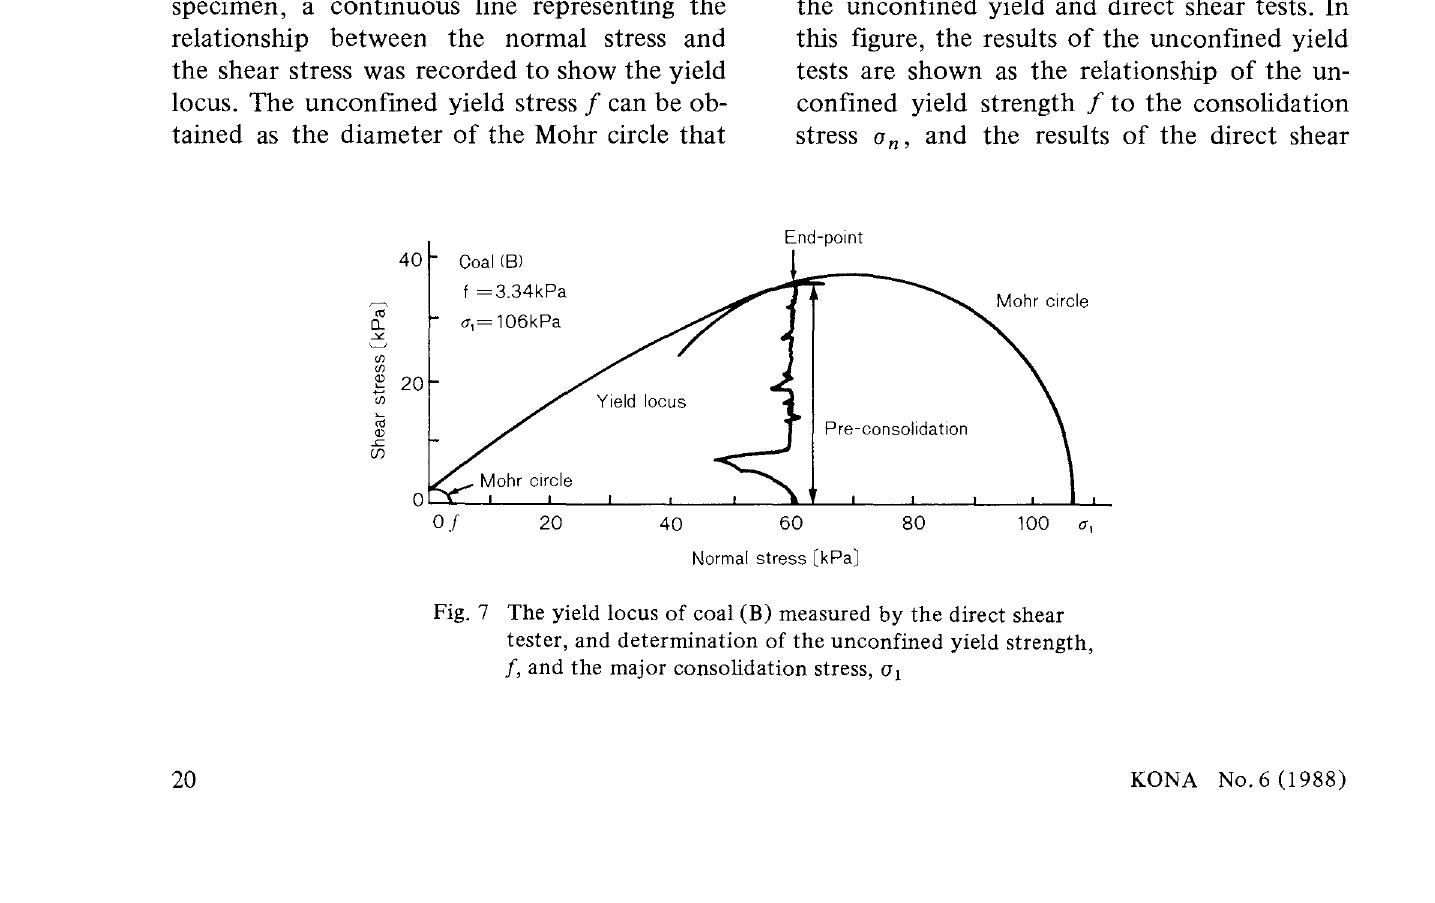
Fig. 7 The yield locus of coal (B) measured by the direct shear tester, and determination of the unconfined yield strength, [,and the major consolidation stress, a